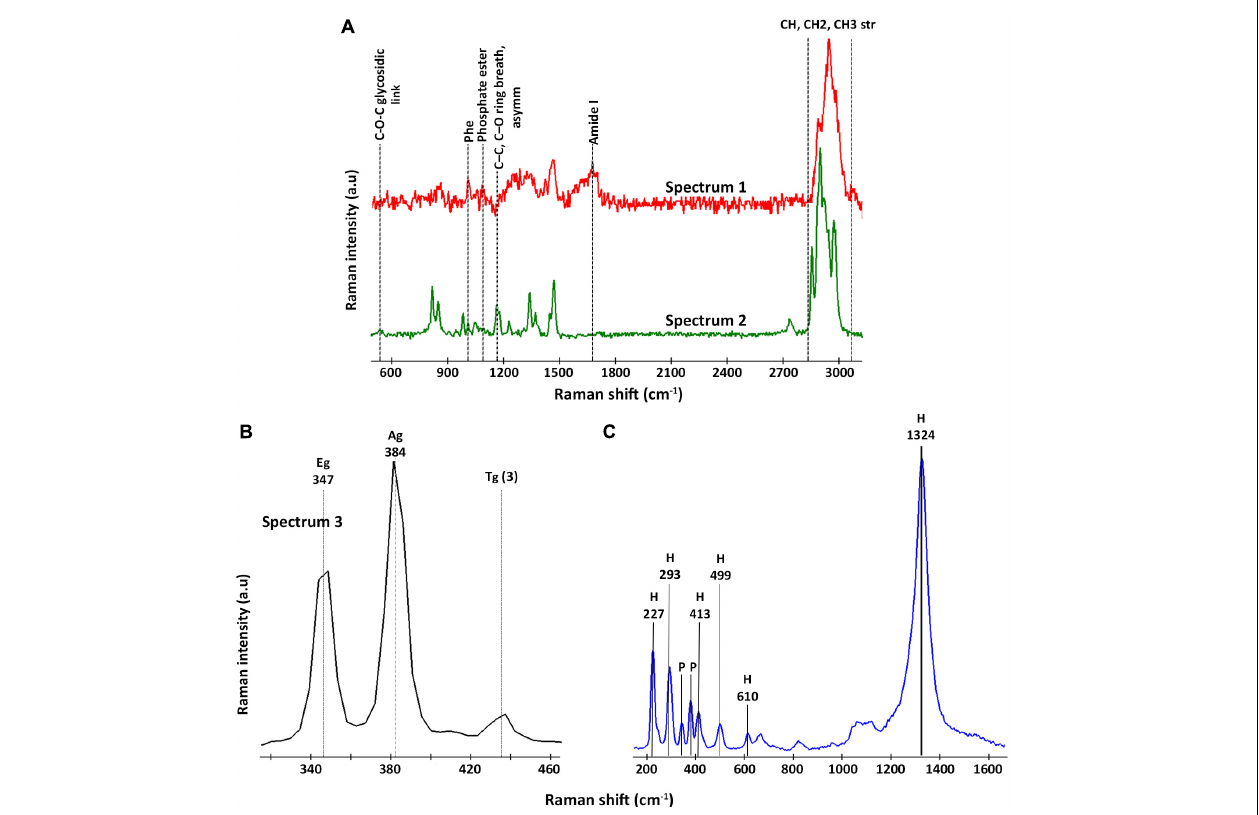
FIGURE 4 | Representative Raman spectra detected by CRM in areas where members of the genus Acidovorax were located by CARD-FISH. (A) Raman spectra assigned to organic matter: in red, spectrum 1/ Acidovorax ; in green, spectrum 2/polysaccharides. (B) Raman spectrum assigned to pyrite (spectrum 3); and (C) Raman spectrum assigned to hematite. The characteristic bands of each spectrum are